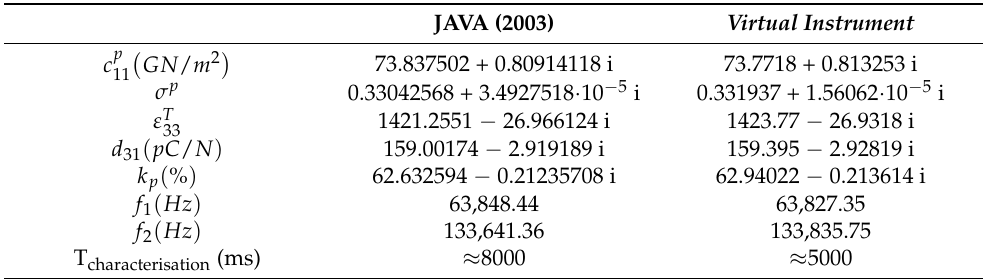
Table 2. Results of the calculation with the JAVA version and the implemented Virtual